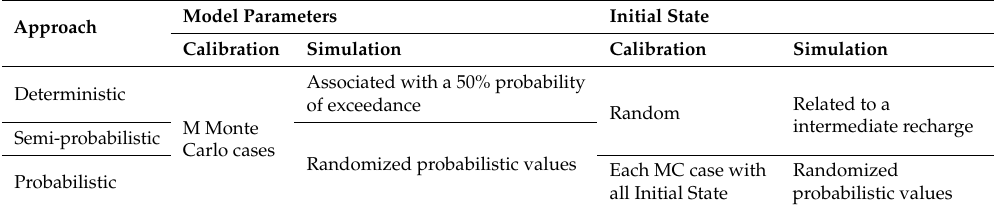
Table 1. Summary of the three calibration–simulation approaches.